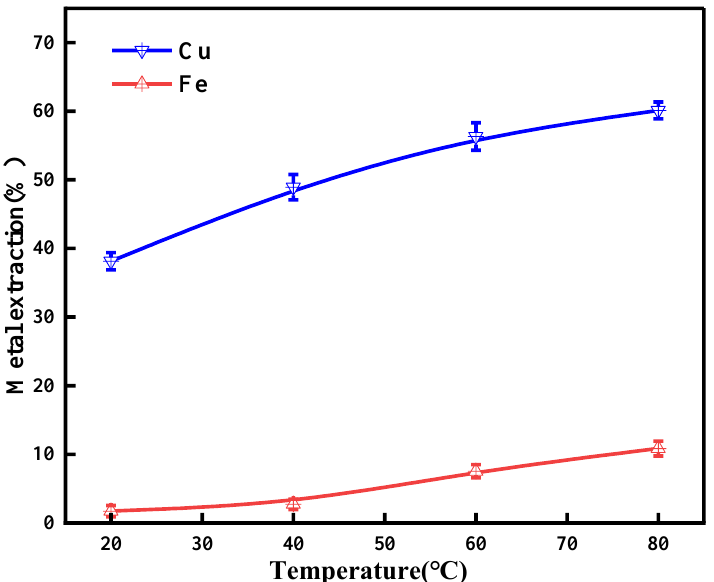
Figure 5. Effect of temperature on metal extractions of COBL ore in agitation leaching. In chemical systems, the increase in reaction time makes the kinetic reaction